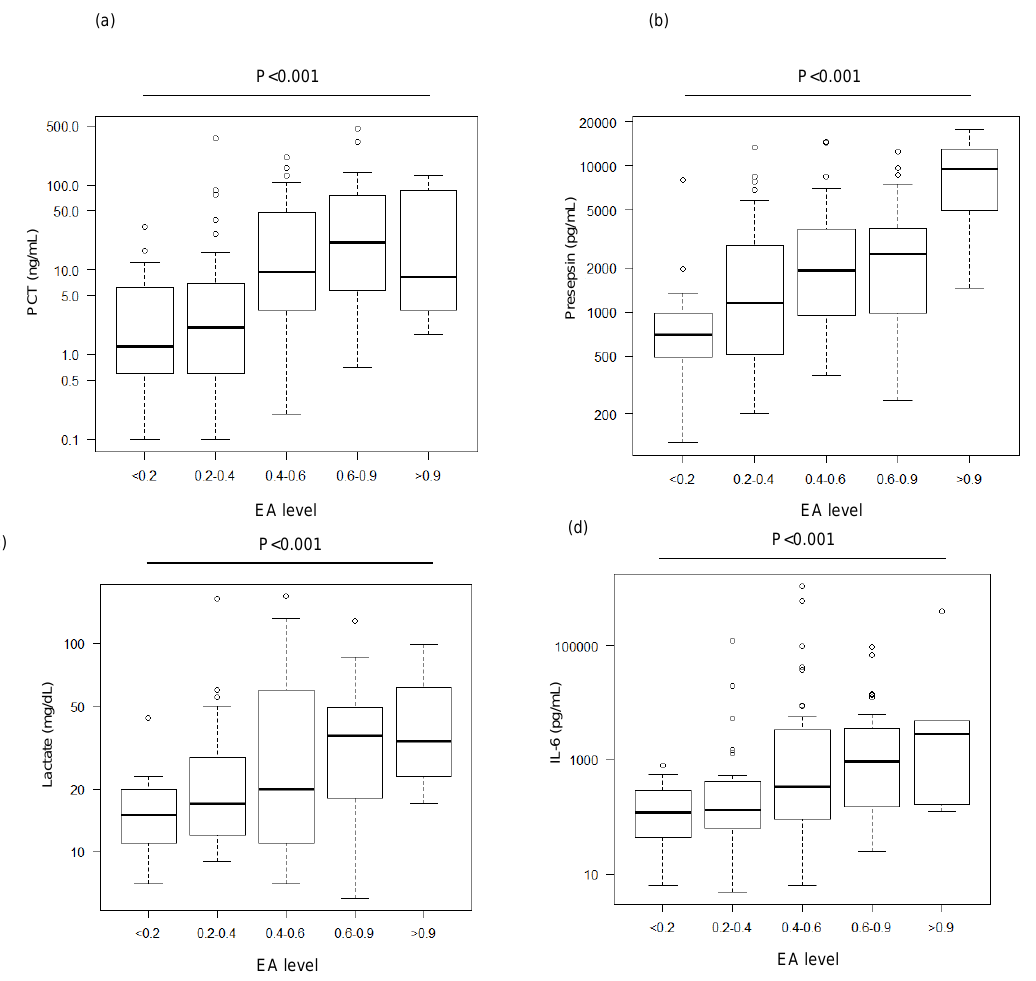
Figure 2. Distribution of various biomarkers’ levels stratified by EA levels. ( a ) procalcitonin (PCT), ( b ) presepsin, ( c ) lactate, and ( d ) interleukin (IL)-6. The data were analyzed by a Jonckheere–Terpstra test after analysis by a Kruskal–Wallis test, which showed significant di ff erences (( a ), ( b ) p < 0.0001, ( c ) p = 0.0154, ( d ) p = 0.0046). Significant di ff erences ( p < 0.001) in all biomarkers were observed between EA